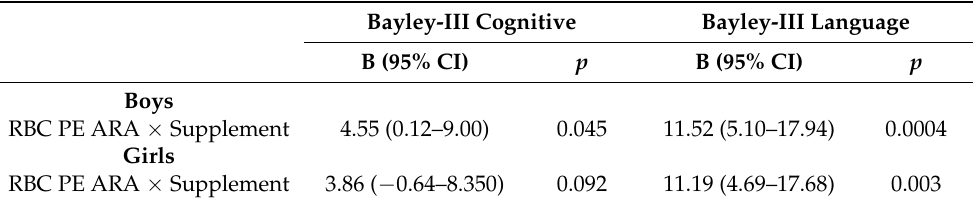
Table 7. Relationships between RBC phosphatidylethanolamine arachidonic acid levels and Bayley-III developmental outcomes in boys and girls at age 24 months.